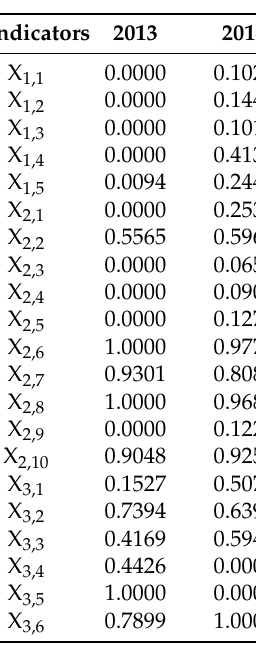
Table 9. Standardization of raw data for each indicator in Beijing.